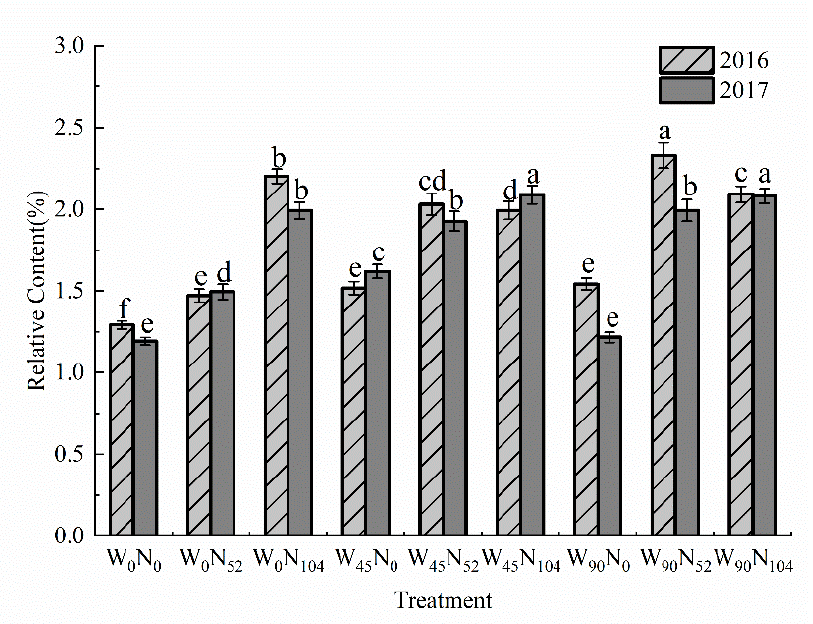
Figure 6. Effects of irrigation, nitrogen application, and the interaction between them on the arginine content of sunflower seed kernels (mean ± SD; different lowercase letters indicate that there are significant differences in nine treatments at the 5% level in 2016 and 2017, respectively).